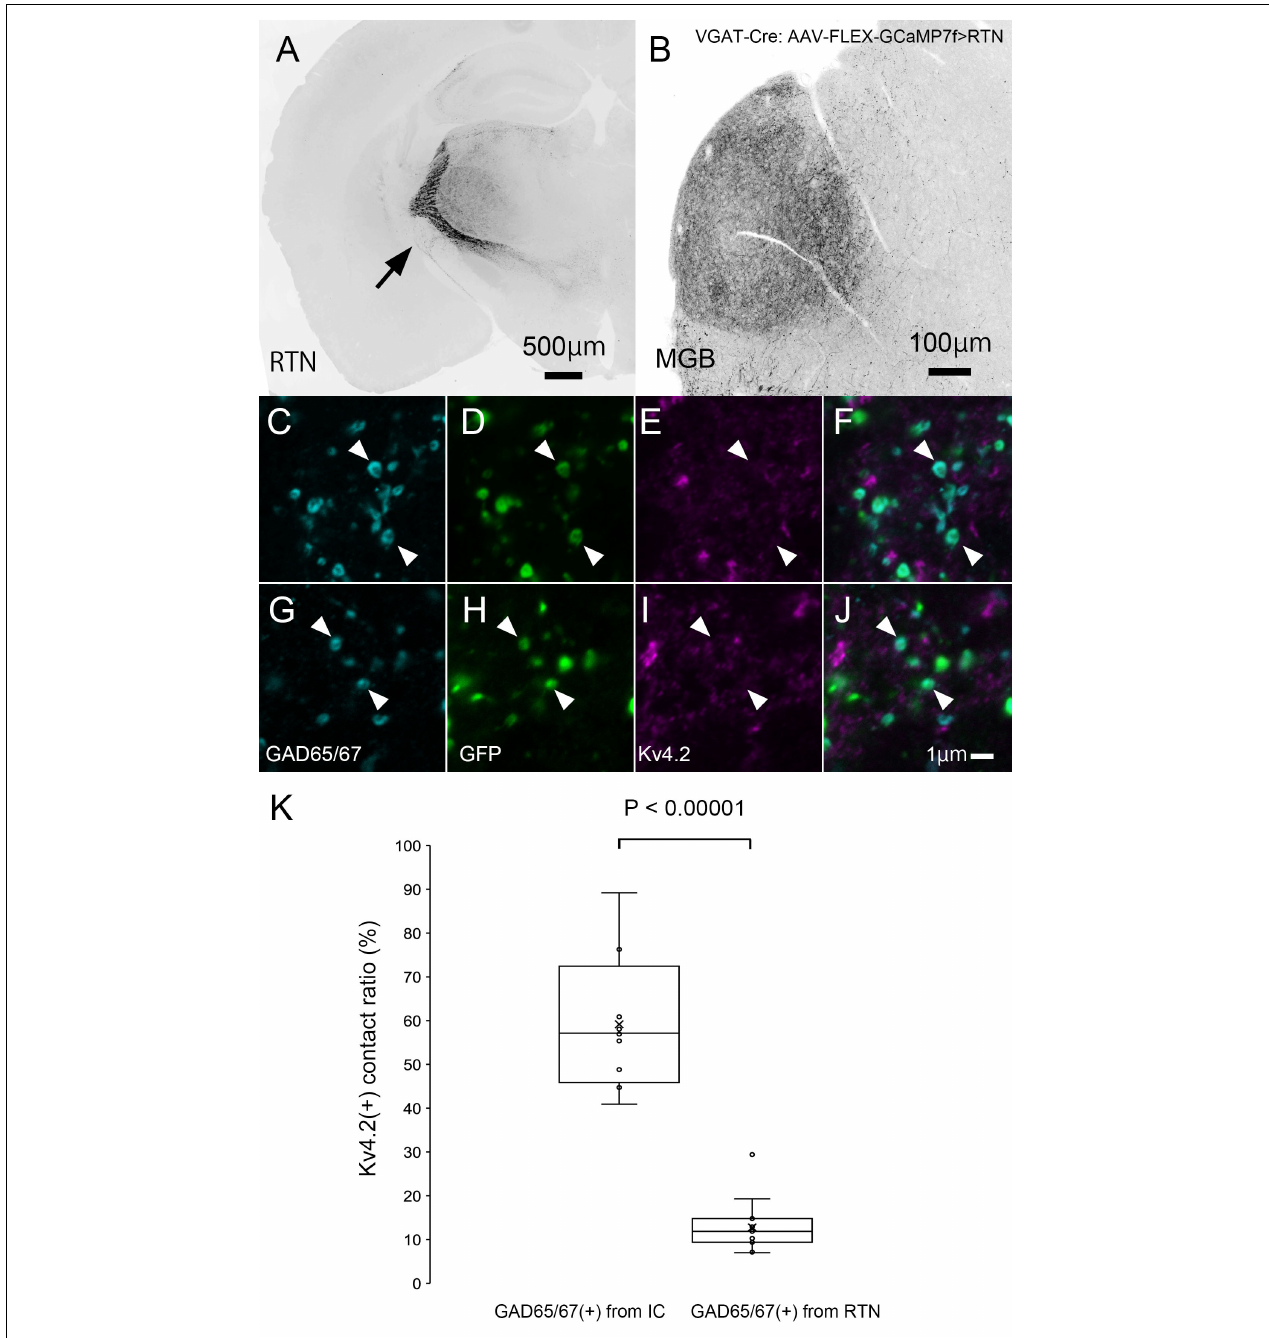
FIGURE 9 | Inhibitory synapse is formed preferentially between Kv4.2-positive MGV microregions and IC axon terminals but not RTN axon terminals. (A) An example of a GFP-immunostained coronal section of RTN showing dense labeling of RTN neurons. (B) GFP-positive axonal plexuses in the MGB. (C–J) Triple fluorescence for GAD65/67 (cyan; C,G ), GFP (green; D,H ), and Kv4.2 (magenta; E,I ) in the MGV of VGAT-Cre mice. Arrowhead: GAD65/67-positive terminal from RTN that does not make a contact with Kv4.2-positive structure. (E,J) Images are acquired from different sections. (K) The ratio of GAD65/67- and GFP-double-positive axon terminals that are in contact with Kv4.2-positive puncta in all GAD65/67- and GFP-double-positive axon terminals is higher from the IC than from RTN regions ( P < 0.00001, t -test). The horizontal lines in the box and whisker plots represent the median values, and the bottom and top of the boxes represent the lower and upper quartiles, respectively. The “x” represents the mean, and the bars represent the minimum and maximum values within 1.5 times the lower and upper quartiles. Scale bar: 500 µ m (A) , 100 µ m (B) , and 1 µ m (C–J) . GAD, glutamic acid decarboxylase; GFP, green fluorescent protein; Kv4, Shal-related subfamily of potassium voltage-gated channel; MGB, medial geniculate body; MGV, ventral medial geniculate; RTN, reticular thalamic nucleus; VGAT, vesicular gamma-amino butyric acid transporter.